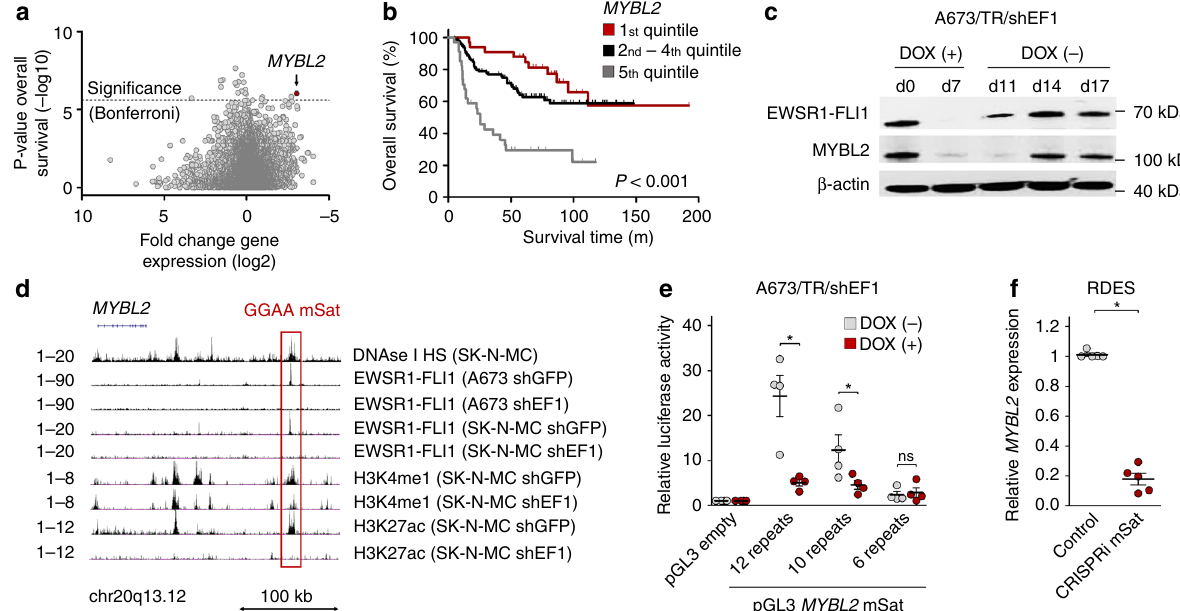
Fig. 1 MYBL2 is a clinically relevant direct EWSR1-FLI1 target gene regulated via a polymorphic GGAA-microsatellite. a Integrative analysis of gene expression microarrays of A673/TR/shEF1 cells pro fi led with/without DOX addition with 166 clinically annotated EwS transcriptomes; P values determined via Mantel – Haenszel test. The dashed line indicates the Bonferroni-adjusted P value threshold. b Kaplan-Meier survival analysis of 166 EwS patients strati fi ed by quintile MYBL2 expression; P value determined via Mantel – Haenszel test. c Western blot using antibodies against (EWSR1)-FLI1 and MYBL2 in A673/TR/shEF1 cells. EWSR1-FLI1 was silenced for 7 days by DOX-treatment and re-expressed after DOX-removal for 10 days. Loading control: β -actin. d Epigenetic pro fi le of the MYBL2 locus in indicated EwS cells transduced with either a control shRNA (shGFP) or a speci fi c shRNA against EWSR1-FLI1 (shEF1) from published DNAse-seq (DNAse I hypersensitivity (HS)) data and ChIP-seq data for EWSR1-FLI1, H3K4me1, and H3K27ac. e Reporter assays of MYBL2 -associated GGAA-microsatellite (mSat) haplotypes in A673/TR/shEF1 cells treated with/without DOX. Horizontal bars represent means, and whiskers represent the SEM, n = 4 biologically independent experiments; P values determined via one-tailed Mann – Whitney test. f Analysis of relative MYBL2 expression by qRT-PCR in RDES EwS cells with/without CRISPRi-mediated targeting of the MYBL2 -associated GGAA-microsatellite. Horizontal bars represent means, and whiskers represent the SEM, n = 5 biologically independent experiments; P values determined via two-tailed Mann – Whitney test. Not signi fi cant, ns; * P < 0.05. Source data are provided as a Source Data fi